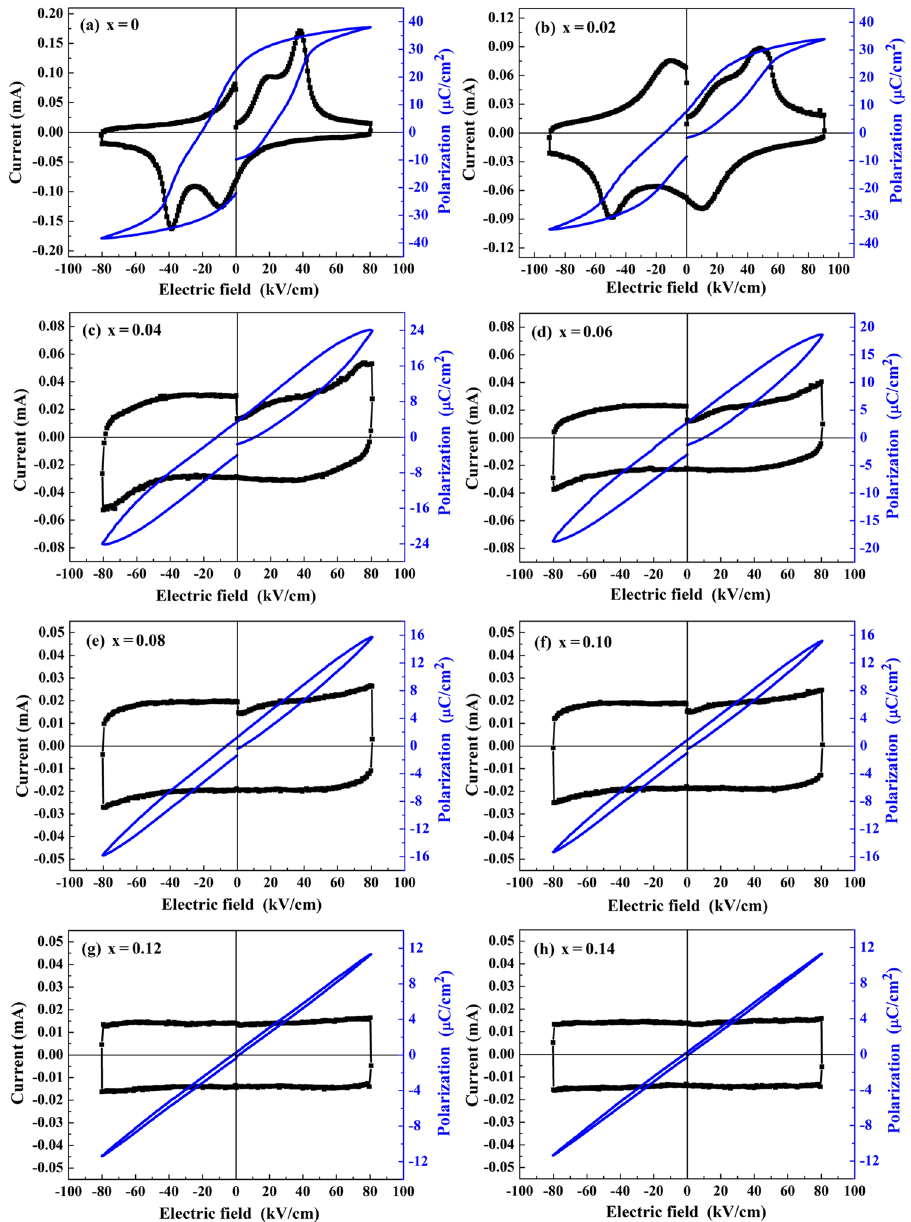
Figure 6. P-I-E plots for the (1-x)LLBNTZ-xNBN ceramics at 90 °C and 10